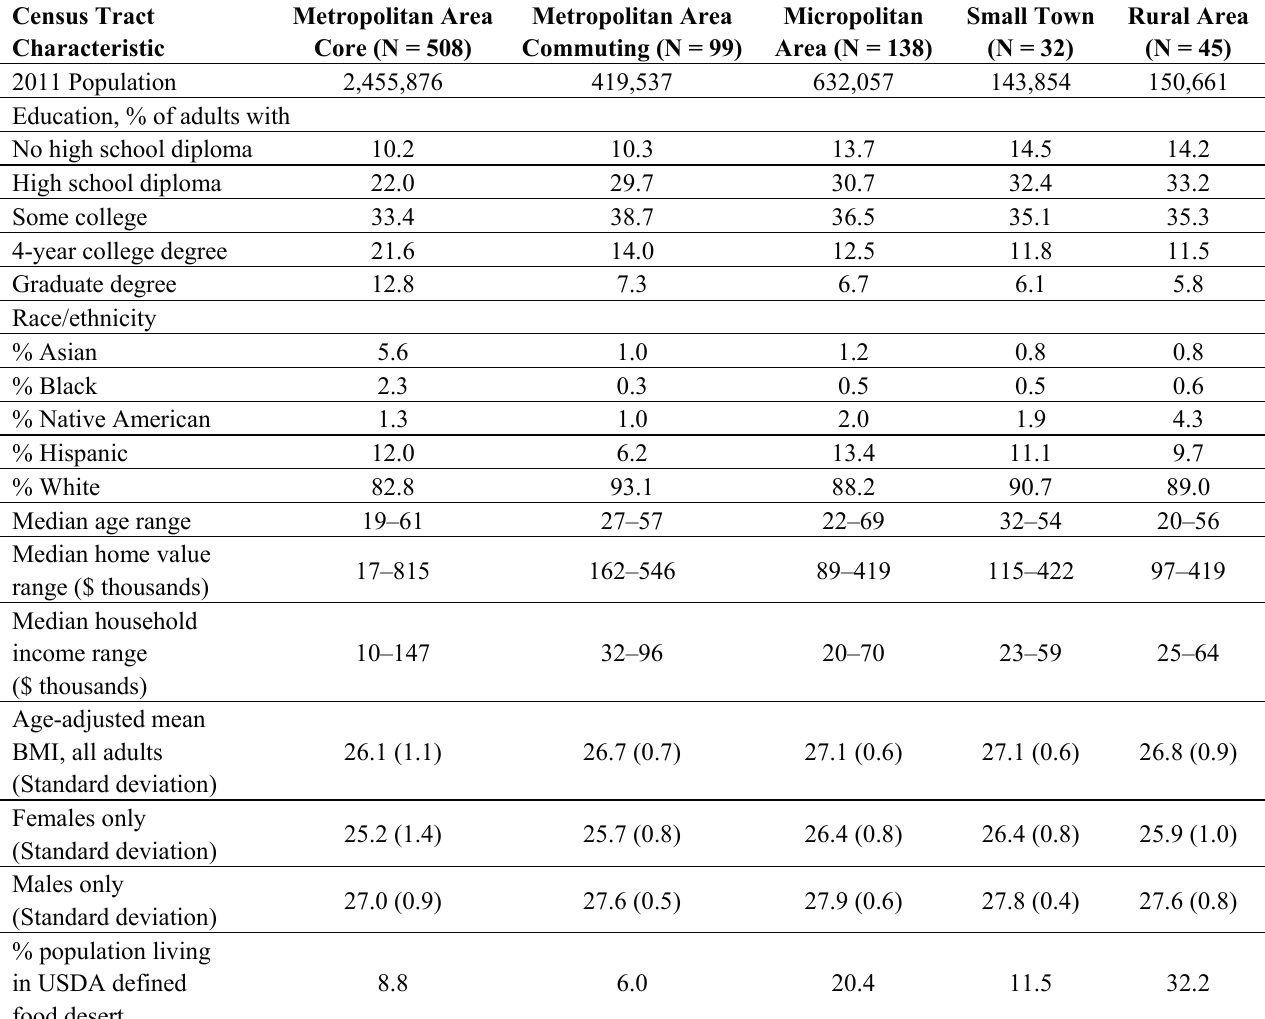
Table 1. Tract level statistics by RUCA